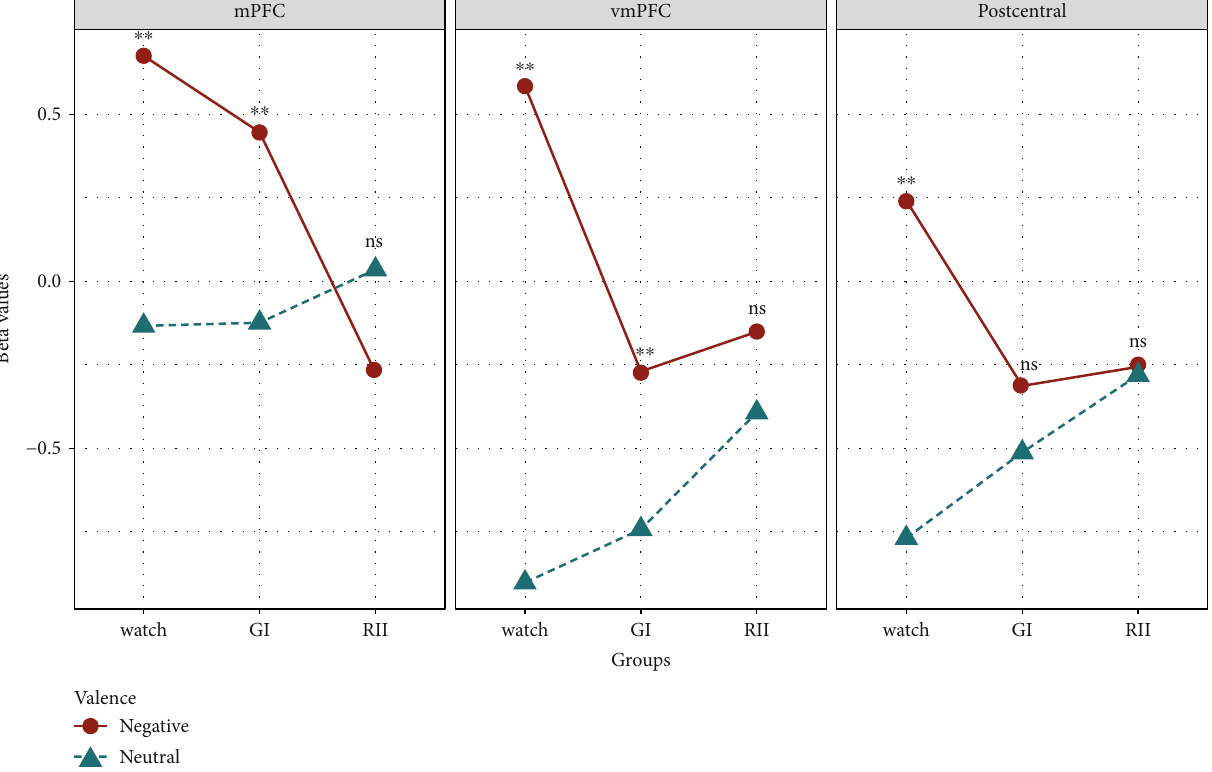
Figure 5: Changes of beta values of activation clusters for the interaction e ff ects (picture type ∗ strategy type). ∗∗ means p < 0 : 01 ; ns stands for not signi fi cant. Table 2: Planned comparisons of functional connectivity intensity between watching, GI, and RII conditions. FC t value GI vs.